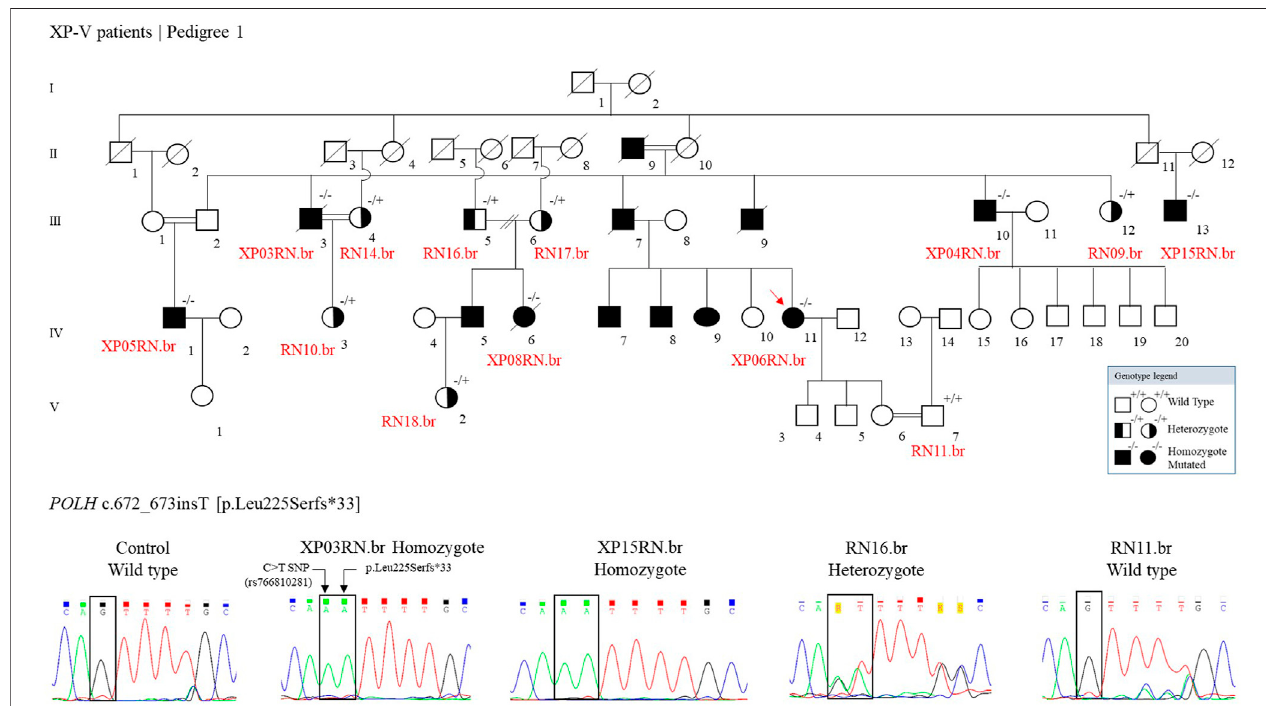
FIGURE3| Thegeneticsegregation ofthep.Leu225Serfs*33mutationwascon fi rmedinthefamiliesfromthecommunity.Genealogy and genotype fromtheXP-V family at Pedigree 1. Electropherogram picture of the Sanger reaction at the POLH mutation site (reverse strand). The p.Leu225Serfs*33 comes alongside a C > T polymorphism (rs766810281) that leads to a synonymous exchange (p.Leu225Leu) and is presented in the Latin American and European populations and is probably segregating with the